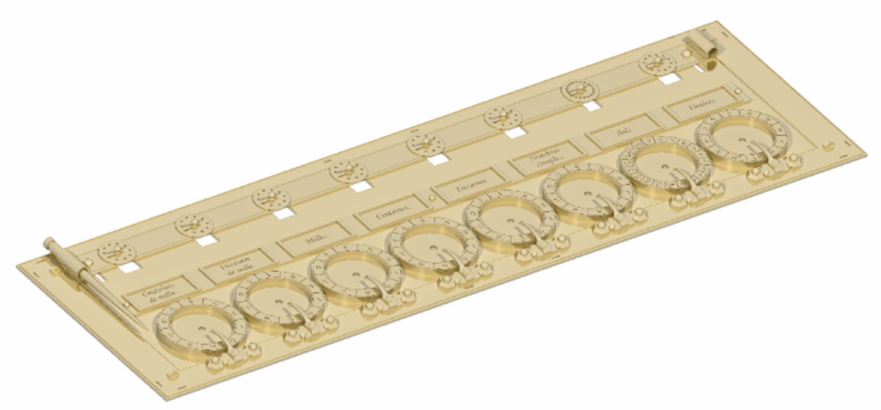
Figure 18. Lid and assembled